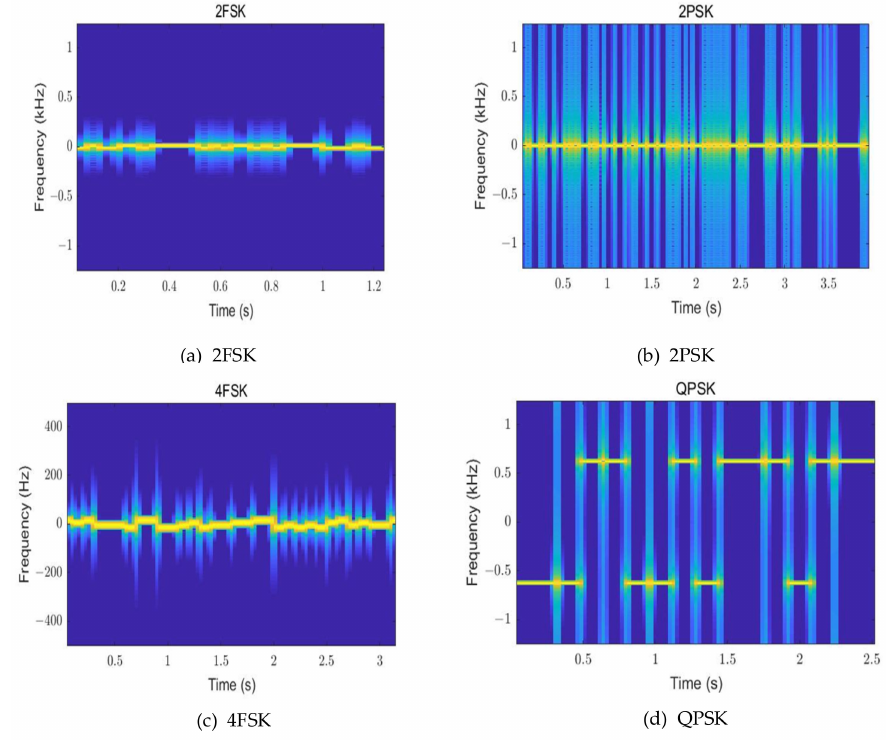
Figure 9. Time-frequency diagram of modulation